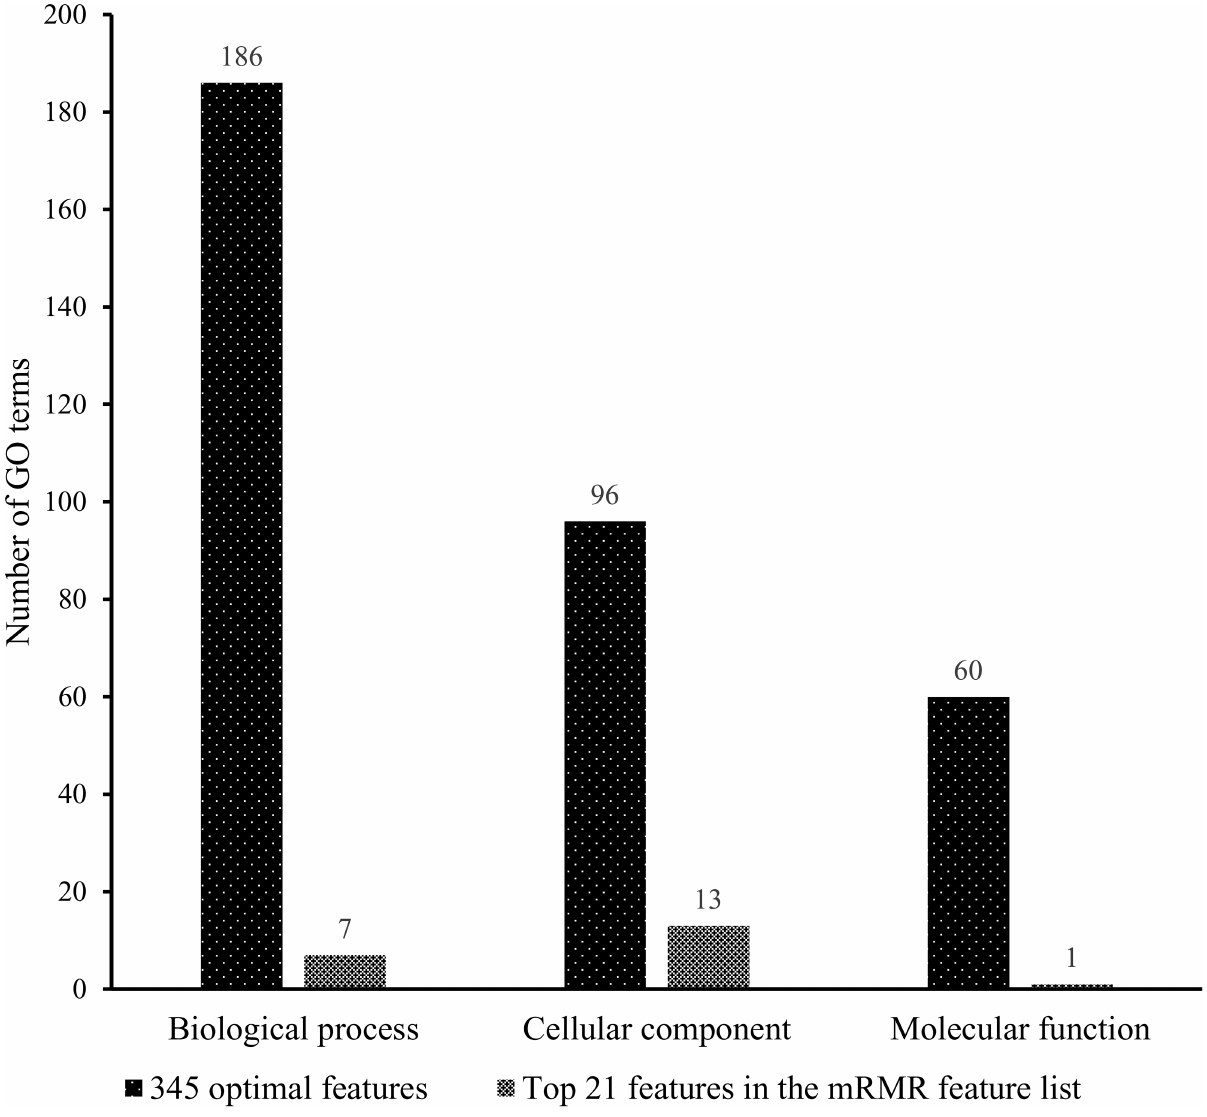
Fig 3. Distribution of the corresponding GO terms of the optimal features and top 21 featuresin the mRMR features in the three groups.